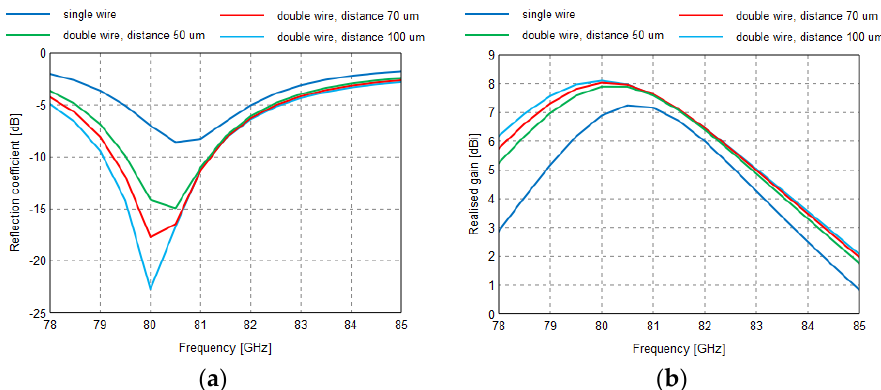
Figure 8. Simulations of the experimental design for different spacing between two parallel wire bonds: ( a ) reflection coefficient; ( b ) realized gain (reflection loss included), broadside direction.